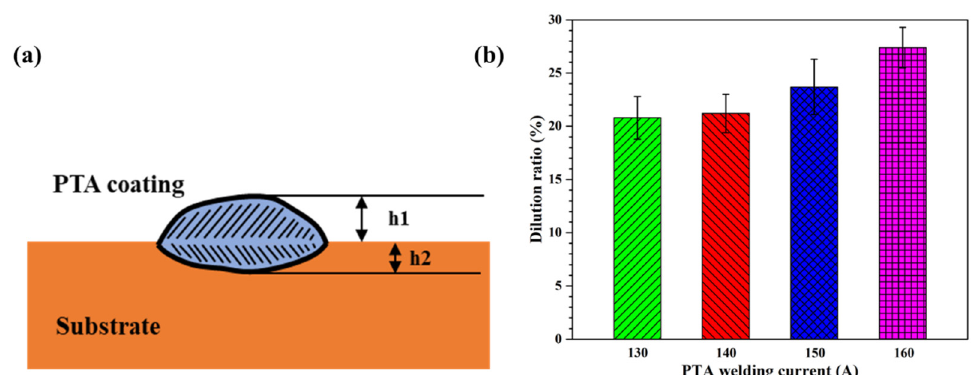
Figure 8. Schematic of the cross-sectional areas used in the calculation of the dilution ratio of the PTA-welded specimen ( a ) and dilution ratio of the Cu35Ni25Co25Cr15 HEA coatings deposited under different welding currents ( b ).